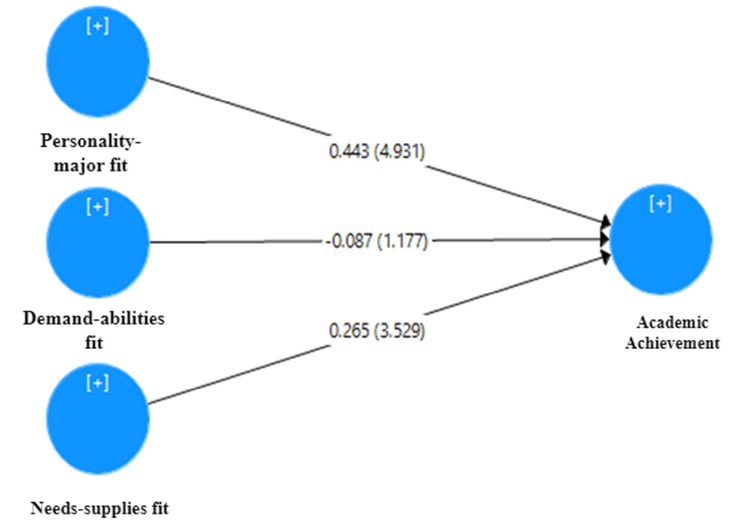
Figure 2. The structural model for academic achievement.